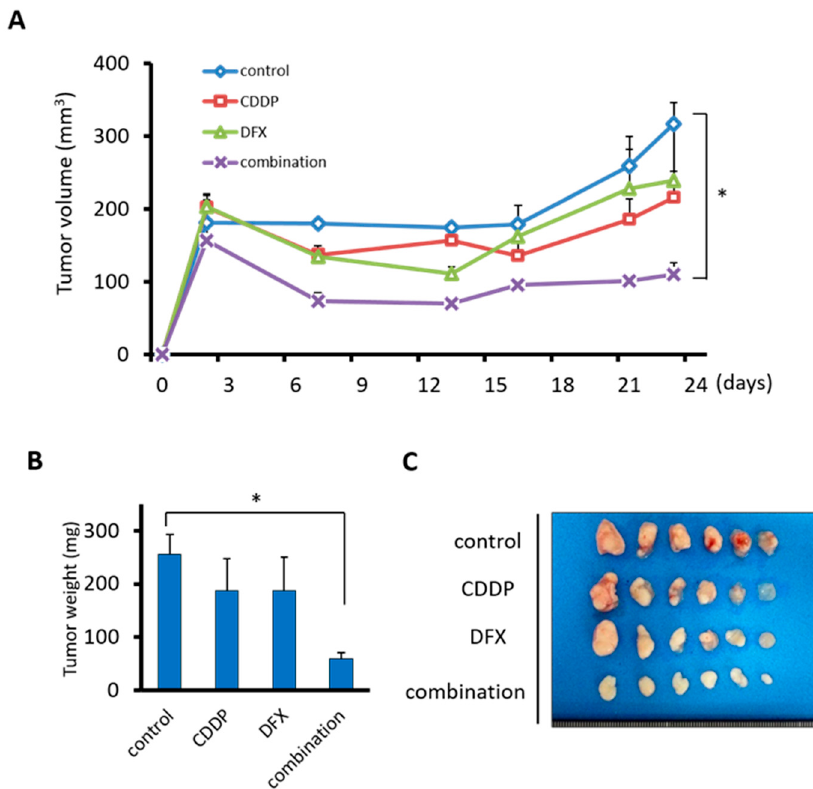
Figure 6. Combination therapy with DFX and CDDP is most effective in suppressing the tumor growth of HSC-2 cells in vivo. ( A ) HSC-2 cells (3 × 10 6 per mouse) were injected subcutaneously into the right flank of 24 mice. On day 2 when the tumors reached 150~200 mm 3 , mice were randomly assigned to one of four groups ( n = 6 per group), and the treatments were initiated as indicated. Tumor size was monitored twice per week. The mean tumor volumes of each group ± S.E.M. and p values for comparison between groups are shown. In the combination group, tumor growth of HSC-2 cells was most effectively and significantly suppressed compared with the control group. * p < 0.05. ( B ) Only the combination therapy significantly suppressed the tumor weight of HSC-2 cells in vivo. * p < 0.05. ( C ) All isolated tumors are shown.